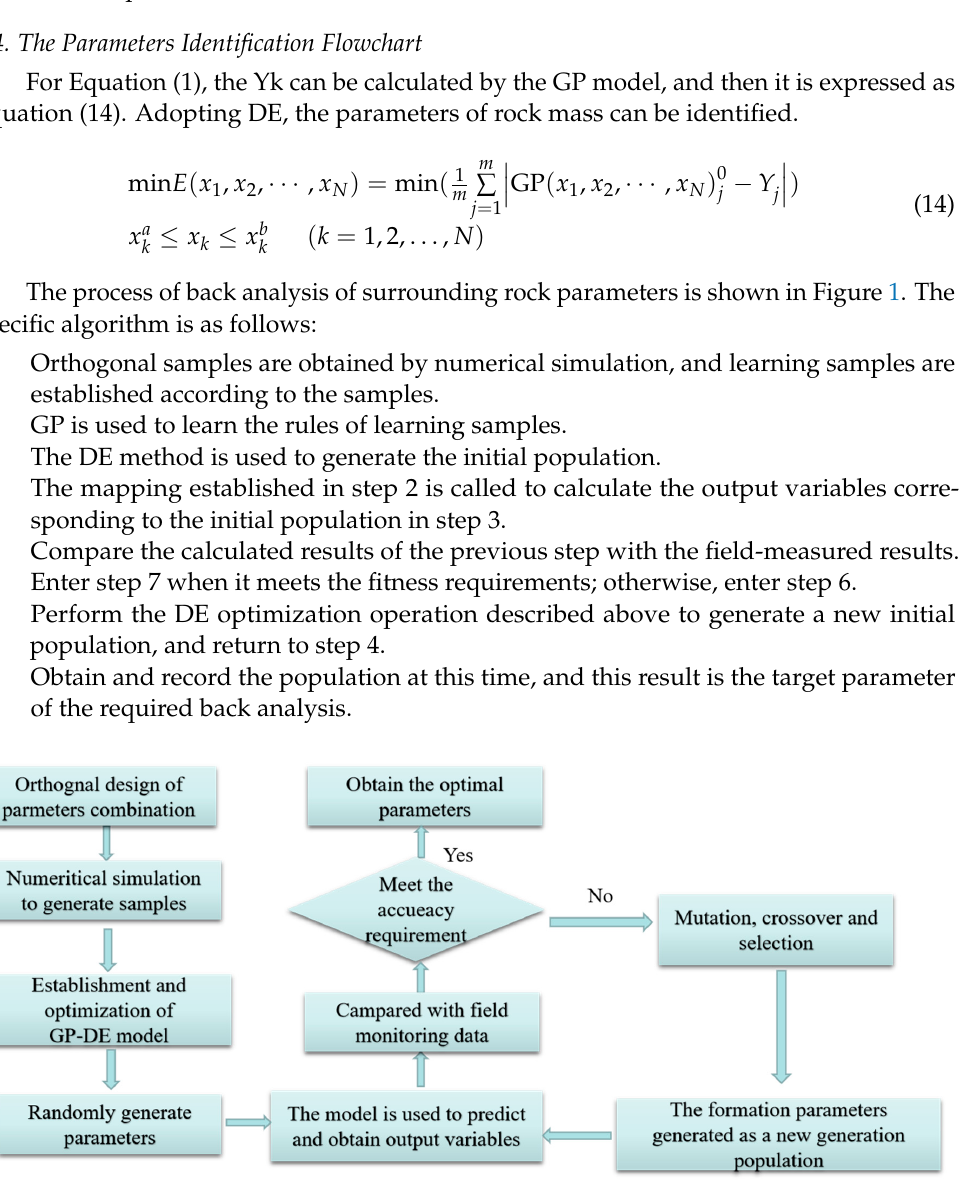
Figure 1. The flow diagram of the anti ‐ analysis method which is based on the GP ‐ DE algorithm.